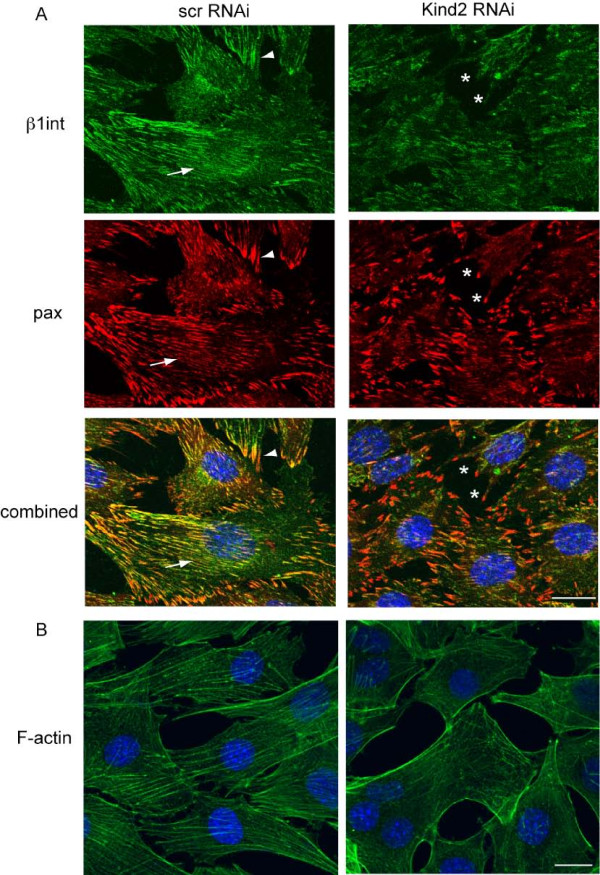
Kindlin-2 knockdown and focal adhesion localization. A. Confocal immunofluorescent microscopy with anti-β1 integrin (green) and anti-paxillin (red) on C2C12 cells transfected with RNAi and then changed to differentiation media for 2 days. Control cells (scr RNAi) show linear staining consistent with localization to costameres (arrows), as well as punctate focal contact staining (arrowheads). Conversely, focal contact proteins in the kindlin-2 RNAi cells fail to form linear structures and instead are concentrated in unusual appearing puncta (*). (Scale bar = 20 μM). B. Oregon Green phalloidin staining on day 2 differentiated C2C12 cells. In the scrambled RNAi myocytes, actin is found primarily in a linear, fiber like pattern. Conversely, in the kindlin-2 RNAi cells it is found concentrated at the membrane. (Scale bar = 20 μM).